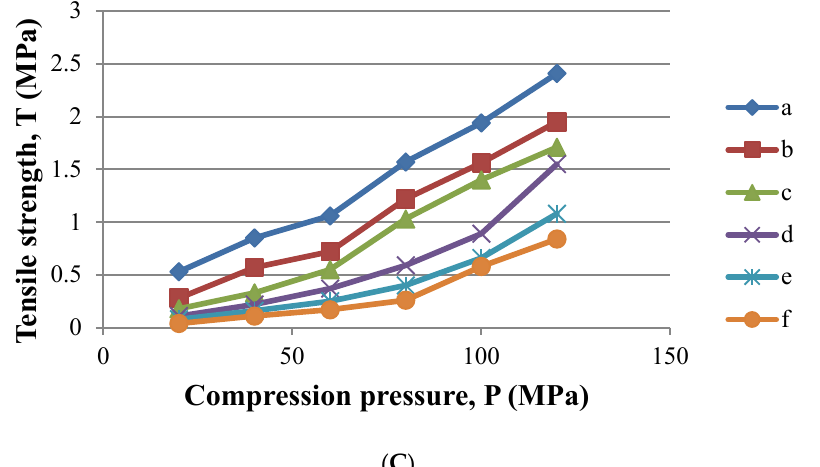
Figure 5. Compaction profile of the excipients ( A ) Avicel PH 101; ( B ) Spress ® B820; ( C ) pregelatinised sago starch and paracetamol mixture of (a) 0% w / w paracetamol; (b) 10% w / w paracetamol; (c) 20% w / w paracetamol; (d) 30% w / w paracetamol; (e) 40% w / w paracetamol; (f) 50% w / w paracetamol. To determine loading capacity of the excipient, plots of the area ratio versus percentage (%) of paracetamol were constructed (Figure 6). Linear regression and back extrapolation to zero area ratios of the plots gave the loading capacity values [10], which reflect the minimum amount of excipient required to form a tablet with the poorly compressible active ingredient, and thus the higher value is preferable. The plots show loading capacity of Avicel PH 101, Spress ® B820 and pregelatinised sago starch relative to paracetamol reached up to 70.16%, 59.16% and 60.97%, respectively.